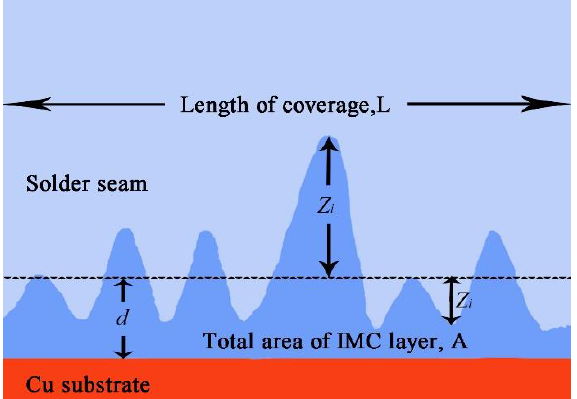
Figure 3. Typical cross section of a solder joints interfacial IMC layer with an average thickness d and roughness R .